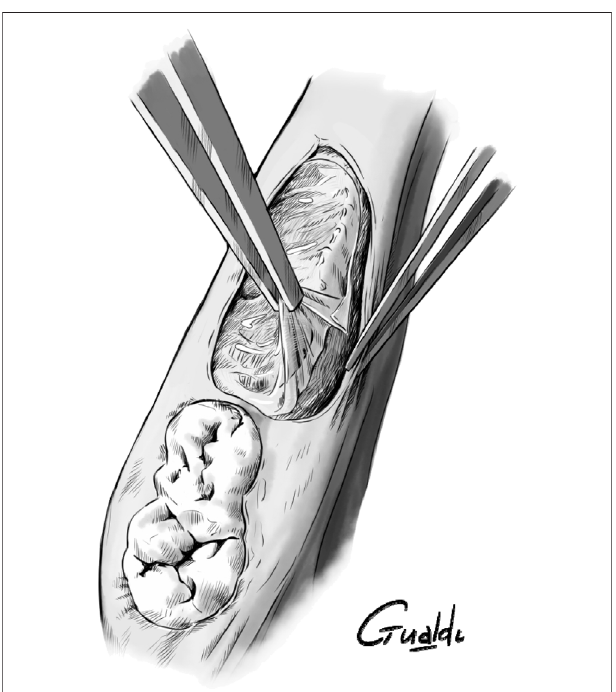
FIGURE 2 | hAM burying between bone and gingiva.